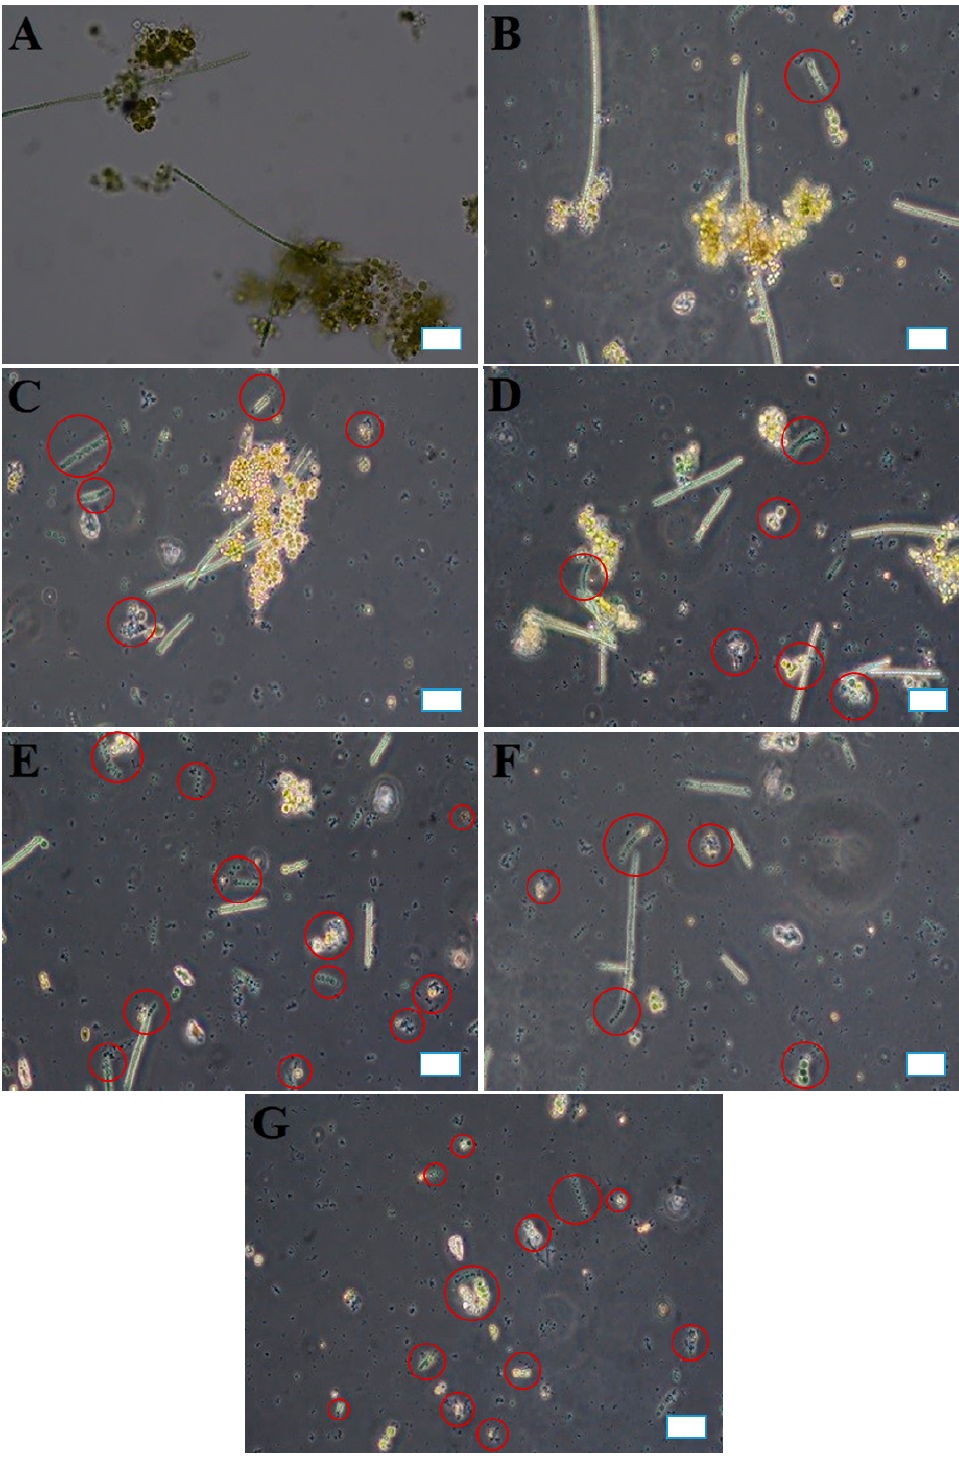
Figure 6. Images of algal cells in co ‐ culture obtained under optical microscopy. ( A ) Control culture without MgAC; ( B ) (1.0 g/L) MgAC ‐ treated mixture cells at day 1; ( C ) cell death occurrence at days 2; ( D ) more encapsulation, fragmentation, and cell death at day 3; ( E ) distortion and death of algal cells at day 4; ( F ) algal cell death at day 5; ( G ) algal cell death at day 6. The red circles indicate the cell fragmentation, lysis, and death. It is noted that the white bars are 10 μ m scale.